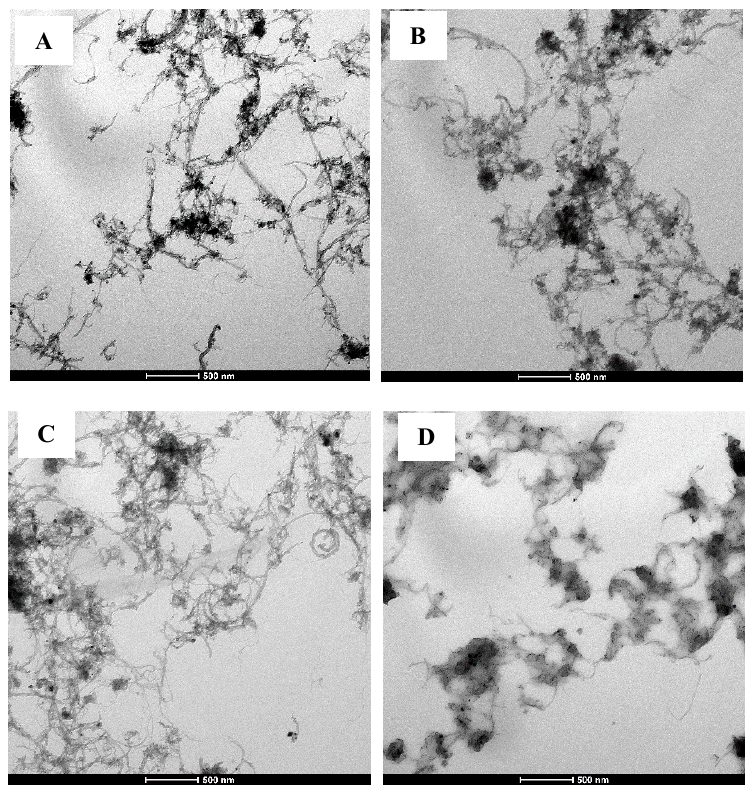
Figure 11. TEM images of ( A ) fMWCNTs, ( B ) fMWCNTs-IL, ( C ) fMWCNTs-mPEG, and ( D ) IL/fMWCNTs-mPEG.